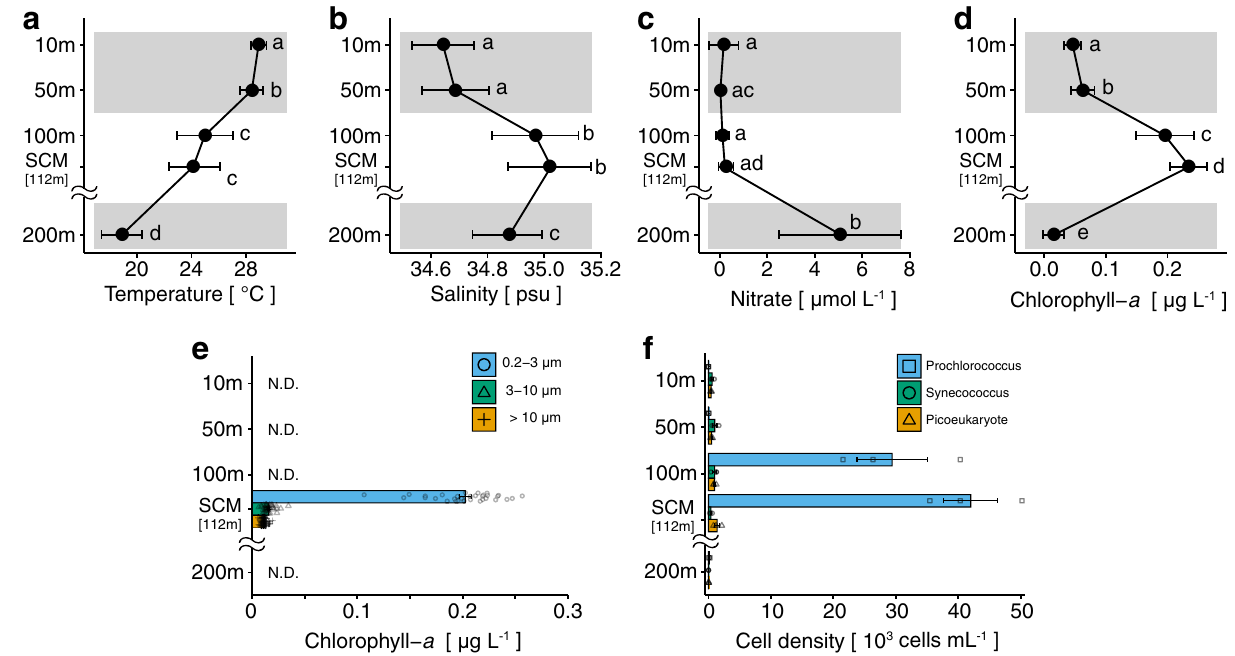
Figure 3. Vertical profiles of environmental factors. Line plots ( a–d ) generated using mean values (circles) of all data with standard deviations (horizontal lines) at five depth layers from all 63 (temperature and salinity) or 38 stations (nitrate and total chlorophyll- a ). SCM refers to subsurface chlorophyll maximum. Gray shading in a–d shows three layers (shallow, 10 and 50 m; middle, 100 m and the SCM; and deep, 200 m) with different characteristics. Letters indicate significant differences in mean values ( p < 0.01) ( a–d ). Chlorophyll- a concentrations of three filter size fractions (0.2–3, 3–10, and > 10 μm) at SCM depth from all 37 stations of total chlorophyll- a stations ( e ). Average cell densities of Prochlorococcus , Synechococcus , and picoeukaryotic phytoplankton ( f ) at five depth layers from all three stations. Prochlorococcus , Synechococcus , and picoeukaryotic phytoplankton did not show significant differences between the two layers ( f ). 112 m is the mean depth of the SCM. Error bars in e and f indicate standard errors of the mean. Data are also available in